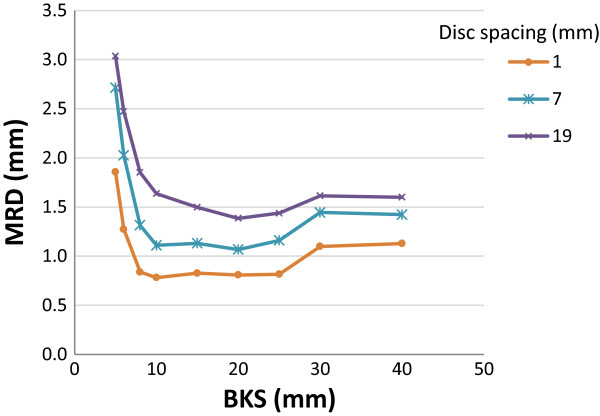
Registration accuracy for varying image feature content. The MRD as function of BKS for phantoms with varying disc spacings (phantom XV-XVII) (see phantom properties in Table 1). Abbreviations: MRD = mean residual displacement, BKS = B-spline knot spacing.